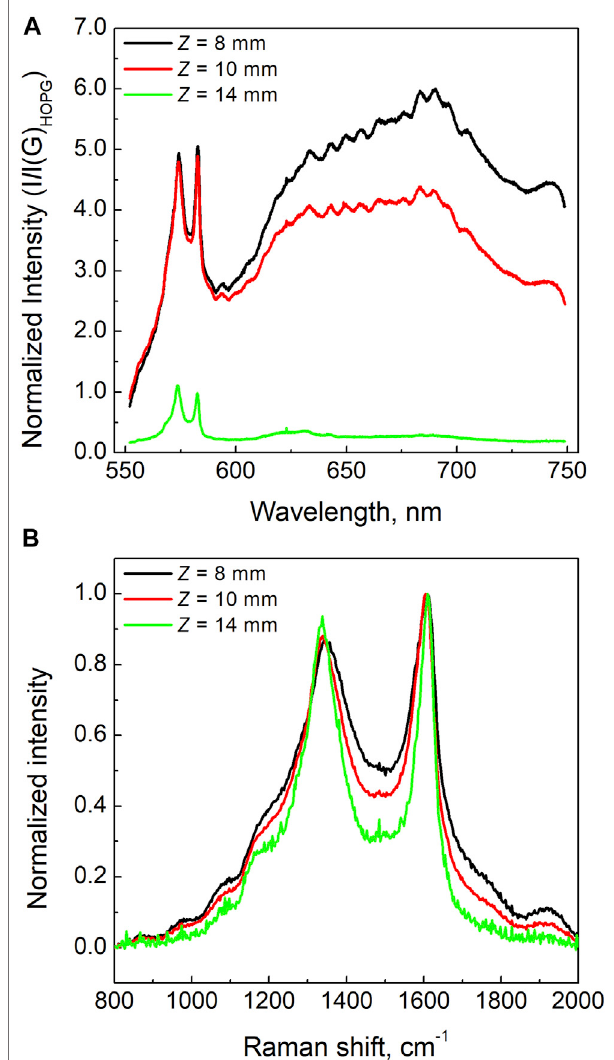
FIGURE 2 | (A) Photoluminescence spectra of the soot samples normalized by the intensity of the G band of HOPG; (B) Raman spectra of three different soot samples background subtracted and normalized to the intensity of the G